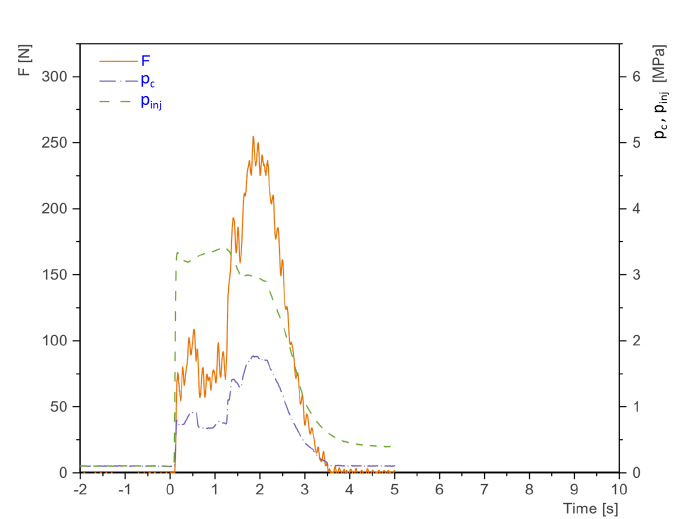
Figure 17. Test data with 8 s burn time and star geometry.